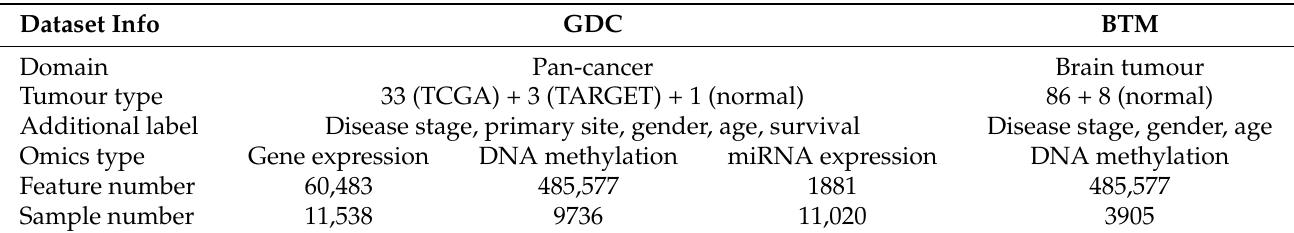
Table 1. Overview information of the Genomic Data Commons (GDC) pan-cancer dataset and the GSE109381 brain tumour methylation (BTM) dataset. The GDC dataset includes two cancer genome programmes: The Cancer Genome Atlas (TCGA) and Therapeutically Applicable Research to Generate Effective Treatment